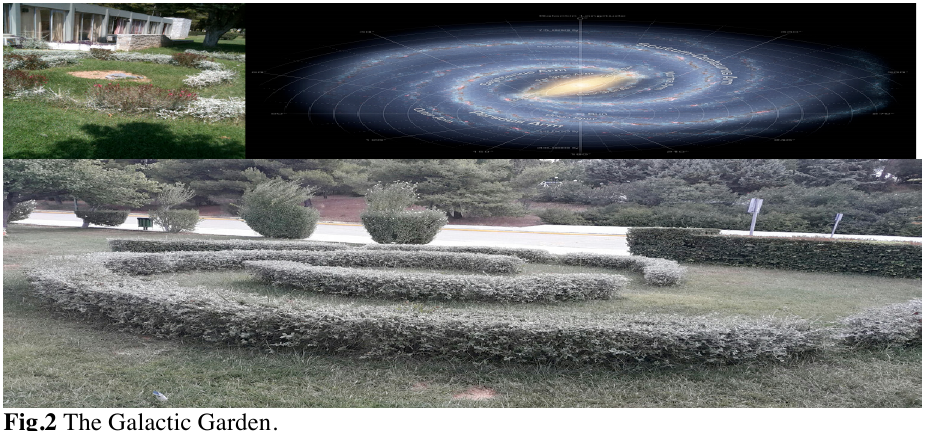
Fig.2 The Galactic Garden.